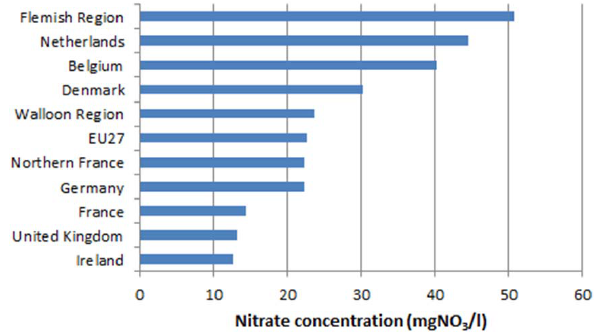
Fig. 8. Percentage of surface water samples in monitoring programs Figure 8. Percentage of surface water samples in monitoring programs for the Nitrates 2 for the Nitrates Directive exceeding 10mgNO 3 L − 1 for the 2nd and 3rd reporting period (European Commission, 2011). * NO 3 data for Directive exceeding 10 mgNO 3 /l for the 2 nd and 3 rd reporting period (European Commission, 3 2000–2003 were not 2011). 4 *NO 3 data for 2000-2003 were not available 5